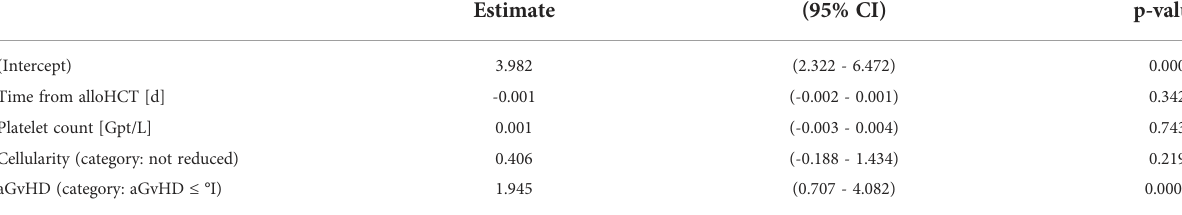
TABLE 2 Multiple linear regression analysis of